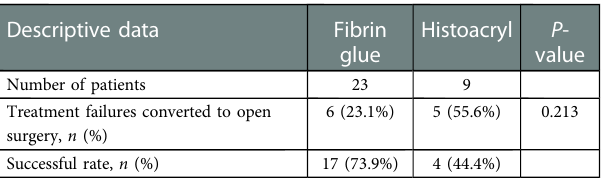
TABLE 4 Summary of results comparing different sealant